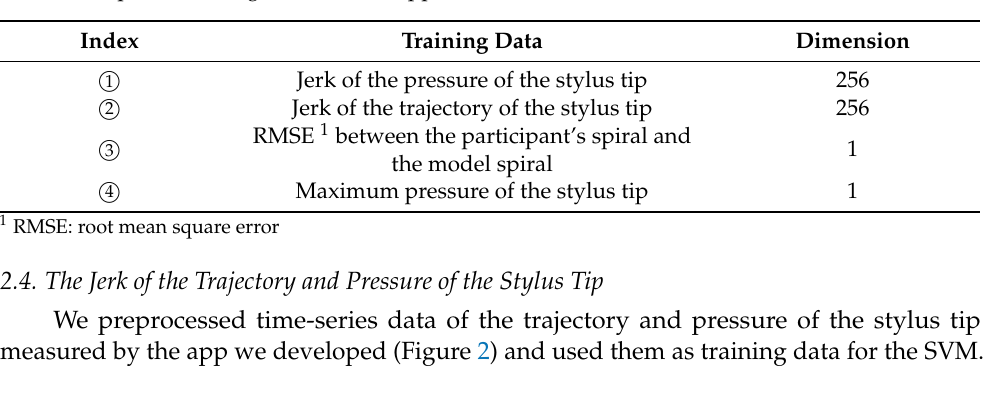
Table 1. Prepared training data for the support vector